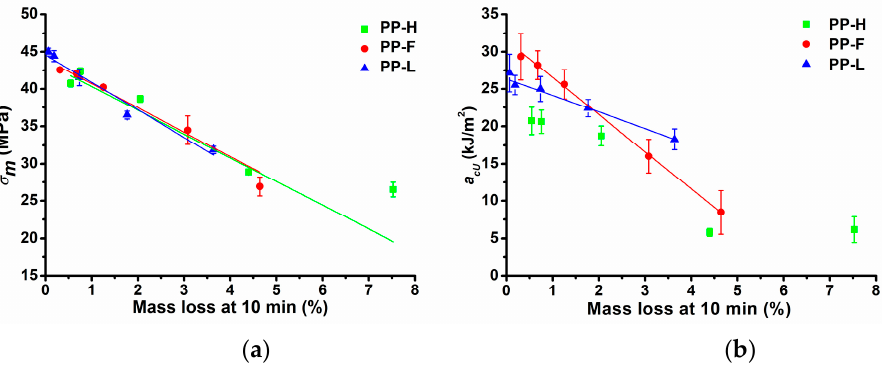
Figure 10. Correlations between the mass loss of fibres at 10 min of isothermal TGA measurements and mechanical properties of composites: ( a ) tensile strength; ( b ) Charpy impact strength.